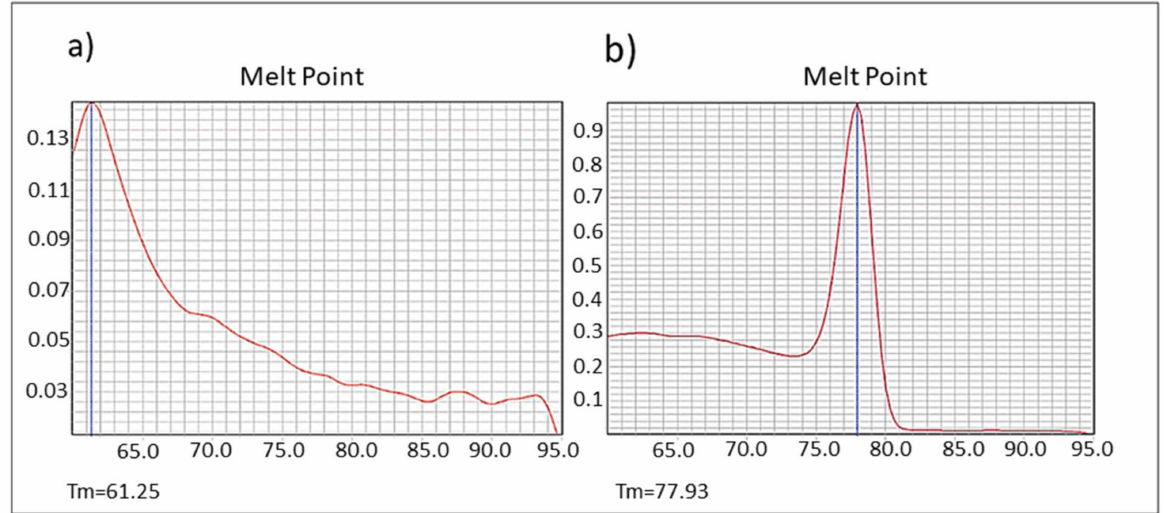
Figure 7. Expression of ard A-H1 in the strain BMB9393 in dsDNA format. ( a ) Melting plot for strain CR15-051 that does not carry ard A-H alleles, showing the expected melting curve for ardA -H1 primers (61–62 ◦ C). ( b ) Melting plot for strain BMB9393 carrying ard A-H1 in the ICE Tn 5801, showing the expected melting curve for ard A-H1 cDNA (77–78 ◦ C) using specific ard A-H1